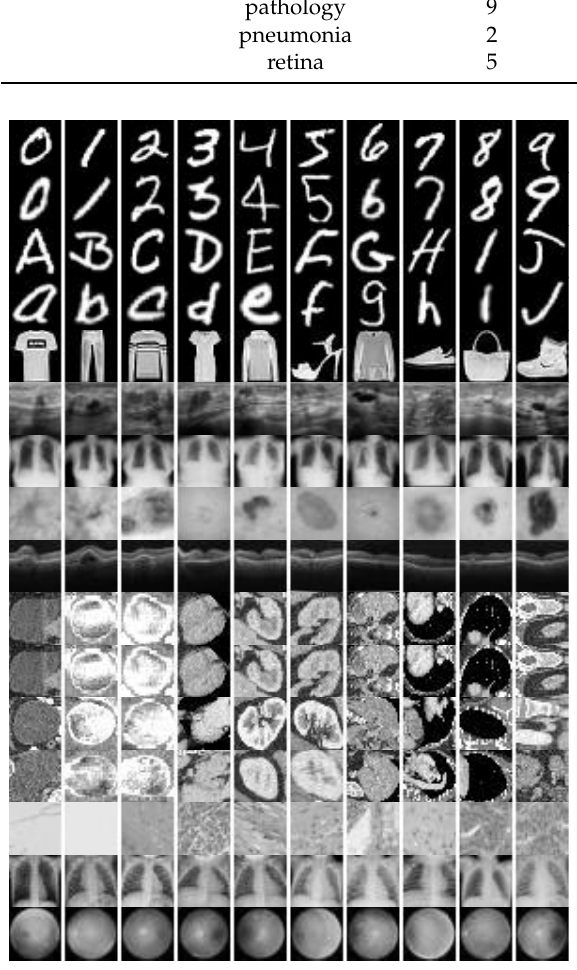
Figure 11. Sample images of experimental data